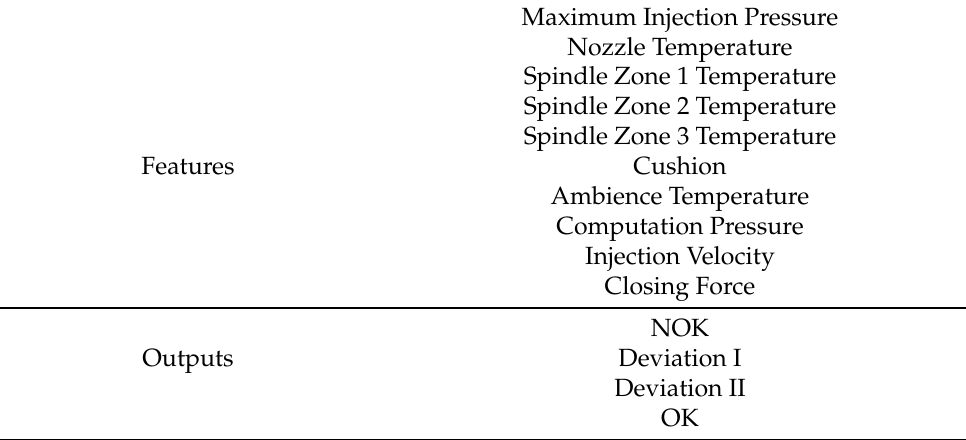
Table 6. Features and Labels of the Tederic